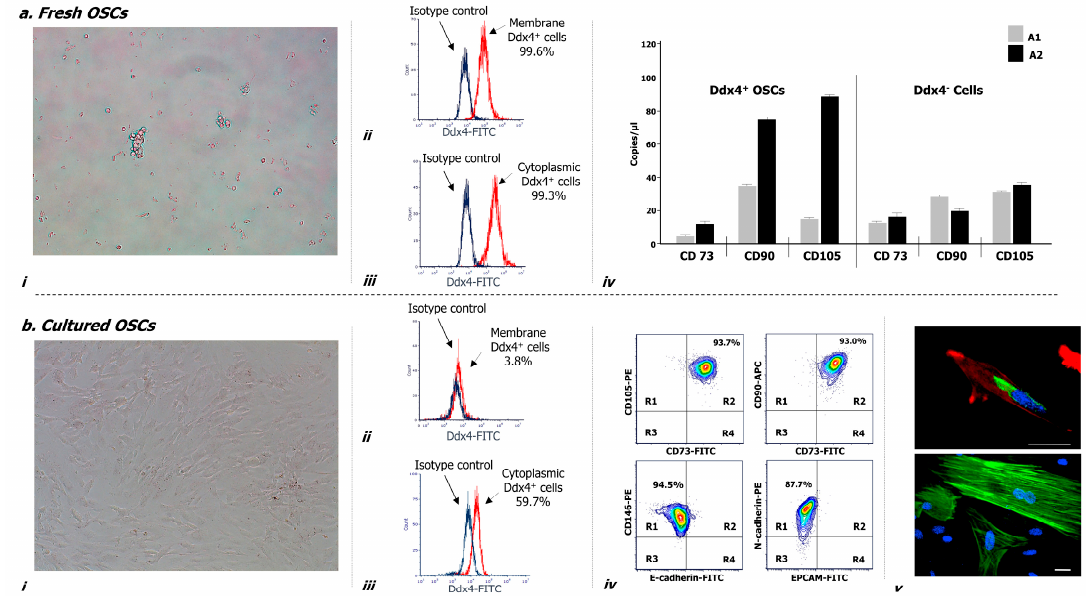
Figure 2. Morphological and molecular characterization of Ddx4 + cells derived from NS-EOC samples, before ( a ) and after two weeks of culture, in the presence of follicle-stimulating hormone (FSH) and epidermal growth factor (EGF) ( b ). ( a ) After their isolation from NS-EOC samples, Ddx4 + cells appeared small and round, singularly distributed or forming small aggregates ( a-i ). Moreover, the majority of these cells ( > 90%) expressed Ddx4, at both membrane ( a-ii ) and cytoplasmic levels ( a-iii ); this was evaluated by flow cytometry either before ( a-ii ) or after permeabilization ( a-iii ) of isolated Ddx4 + cells, processed with an FITC-conjugated anti-rabbit antibody (in red: positive staining for Ddx4; in blue: isotype control). The native tendency of Ddx4 + cells to undergo ML di ff erentiation was revealed by droplet digital PCR (ddPCR), which showed the baseline expression of CD73, CD90, and CD105 genes in Ddx4 + cells from OC patients, at a significantly higher extent ( p < 0.02) in those derived from A2 tumors. On the other hand, Ddx4-negative cells from both groups of OC patients expressed significantly lower levels of the mesenchymal markers than those found in A2-derived Ddx4 + cells ( p < 0.02) ( a-iv ). The results are expressed as mean values ± standard deviation (SD) of experiments performed in triplicate. ( b ) After the first week of culture, in the presence of FSH and EGF, tumor-derived Ddx4 + cells acquired a fibroblast-like shape ( b-i ), while varying their Ddx4 expression, which decreased on the cell membrane ( b-ii ) but was maintained in the cytoplasm of 59.7% cells ( b-iii ). Flow-cytometry analysis revealed the concomitant expression of multiple mesenchymal markers on the majority of 14 day-cultured ML-Ddx4 + cells, whereas the expression of either E-cadherin or Epithelial cell adhesion molecule (EPCAM) was poorly detectable. The representative contour plots in ( b-iv ) show in R2 quadrants of the upper panels the co-expression of CD73 with CD105 (93.7%), and CD73 with CD90 (93.0%), in the analyzed cell population. Moreover, as shown in the lower panels, related to cells double-stained for mesenchymal and epithelial markers, the localization of the cell population in the R1 quadrant suggested that only CD146 and N-cadherin were expressed, whereas E-Cadherin and EPCAM were detected on a very small cell fraction (range: 1–5%) ( b-iv ). We further confirmed the acquisition of a fibroblast-like shape by confocal microscopy ( b - v ), together with cytoplasmic and perinuclear Ddx4 localization (up: Ddx4 in green, actin in red, nuclei in blue; down: actin in green, nuclei in blue). Scale bars: 20 µ